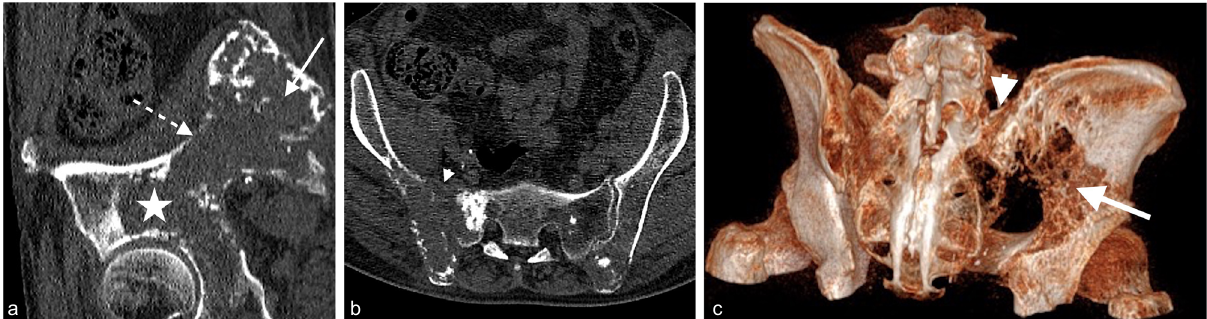
Figure 1. (a) Oblique sagittal reformatted view of pre-treatment CT (bone window, slice thickness 1 mm) of the iliac bone shows the extensive lesion involving the iliac wing (arrow), arcuate line (dotted arrow) and acetabulum (star). (b) Oblique axial reformatted view of pre- treatment CT (bone window, slice thickness 1 mm) of the pelvic bones shows the extensive lesion involving both the iliac bone and the sacral wing (arrowhead). (c) 3D oblique posterior reformatted view of the pelvic bones shows the extensive osteolytic lesion involving the iliac wing (arrow) and the sacral wing (arrowhead) greatly compromising pelvis